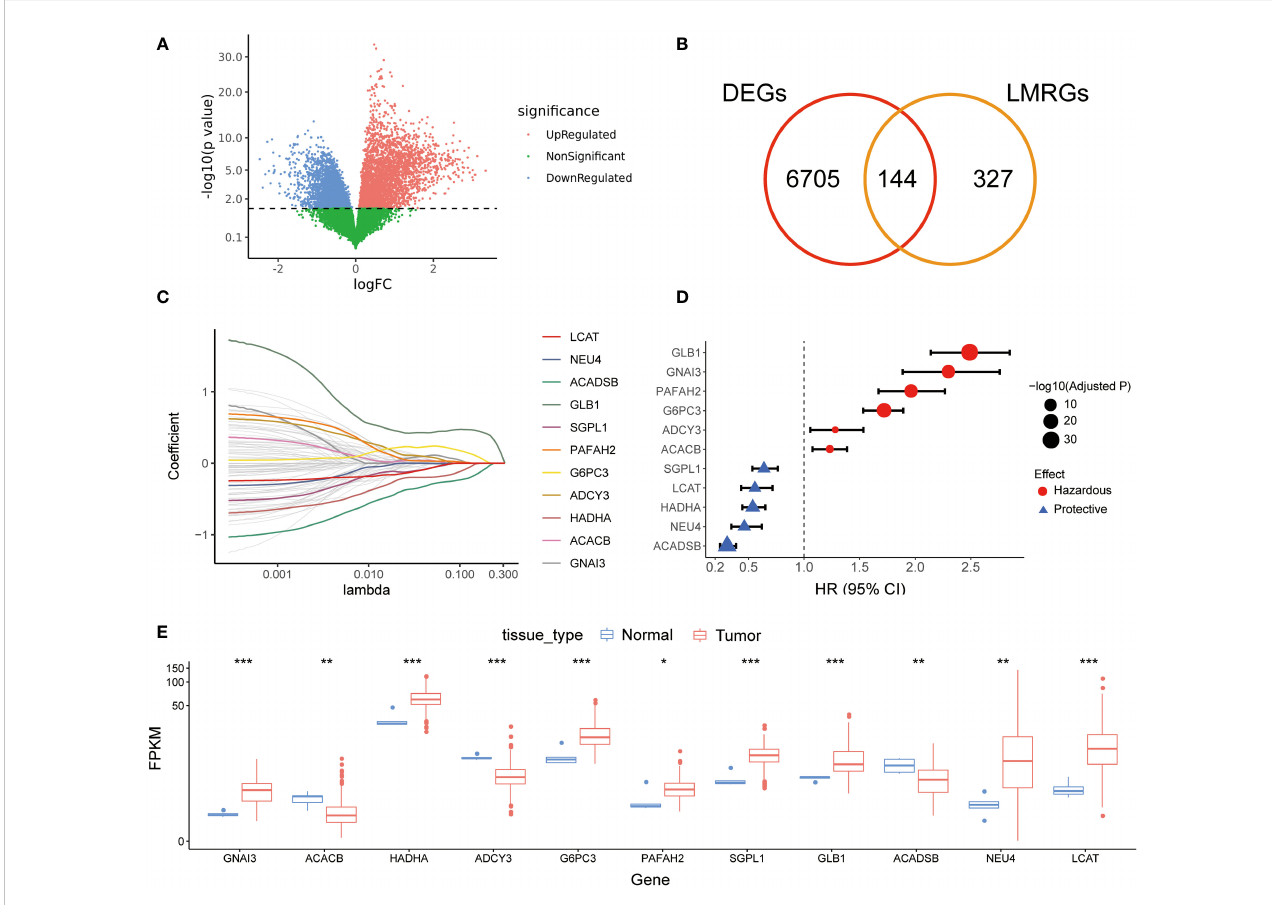
FIGURE 2 Screening of prognostic LMRGs. (A) , DEGs between gliomas and normal brains in TCGA cohort; (B) Venn diagram for screening common genes in DEGs and LMRGs; (C) LASSO Cox regression for screening reliable prognostic LMRGs; (D) Forest plot of 11 prognostic LMRGs; (E) Expression levels of 11 prognostic LMRGs in tumor tissues and normal brains. LMRG, lipid metabolism-related gene; DEG, different expression gene; LASSO, least absolute shrinkage and selection operator. * indicated p<0.05, whereas ** p<0.01, *** p<0.001 in the current